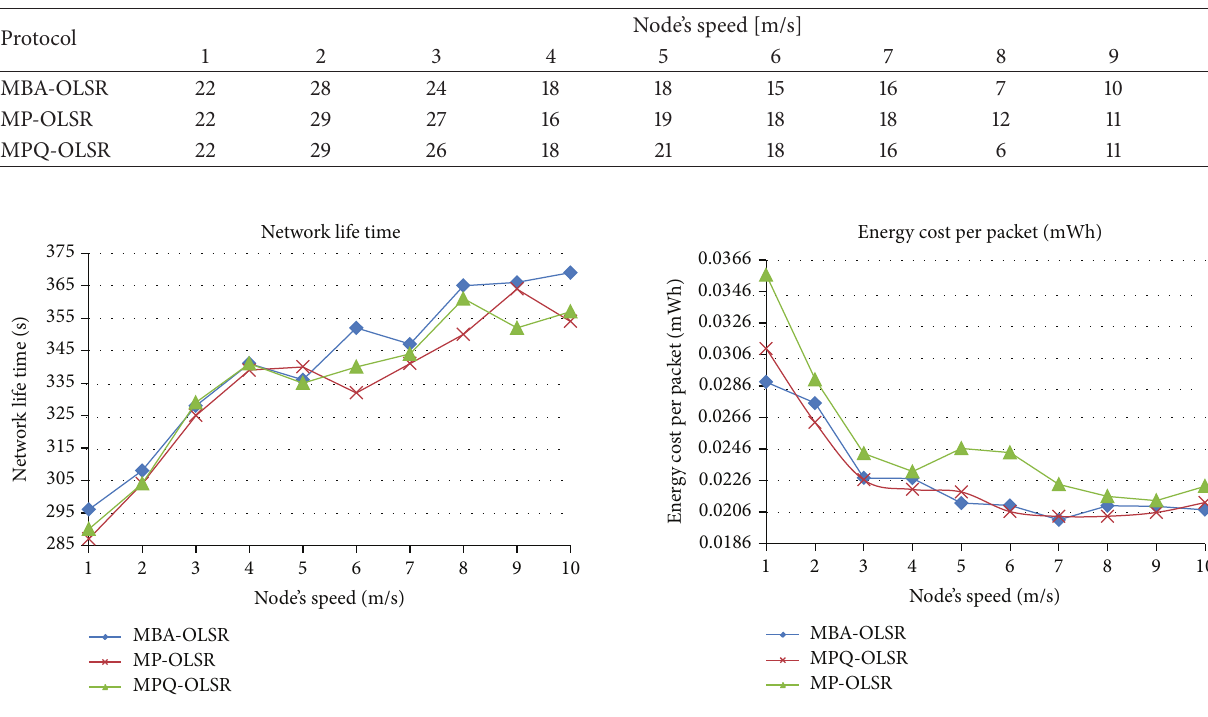
Figure 12: Network lifetime for varying speed. Figure 13: Energy cost per packet for varying speed.